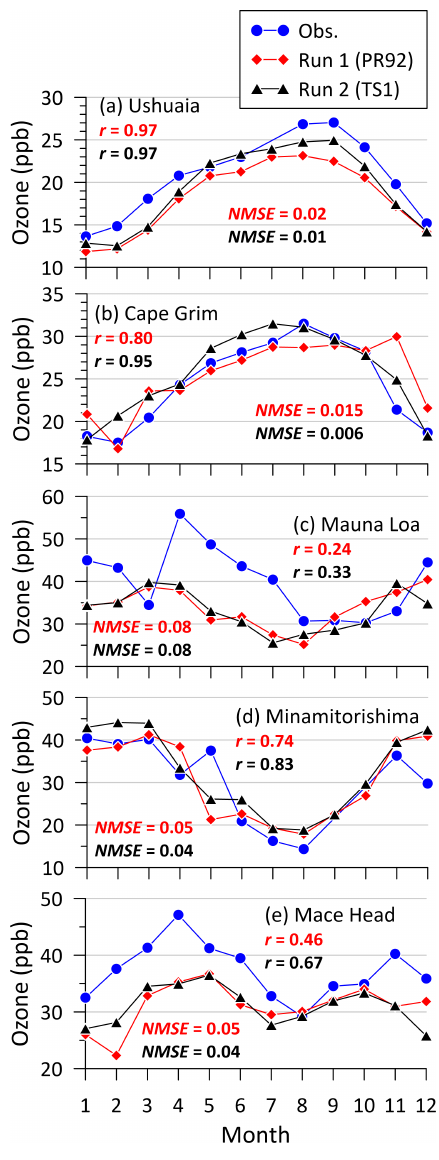
Figure 12. Comparison of the modelled monthly averaged ozone concentrations with observations at five oceanic/coastal ground sta- tions for the year 2006. The two model runs are with the default PR92 parameterisations (Run 1) and new lightning flash-rate pa- rameterisations (Run 2, this study). The values of r and NMSE are also